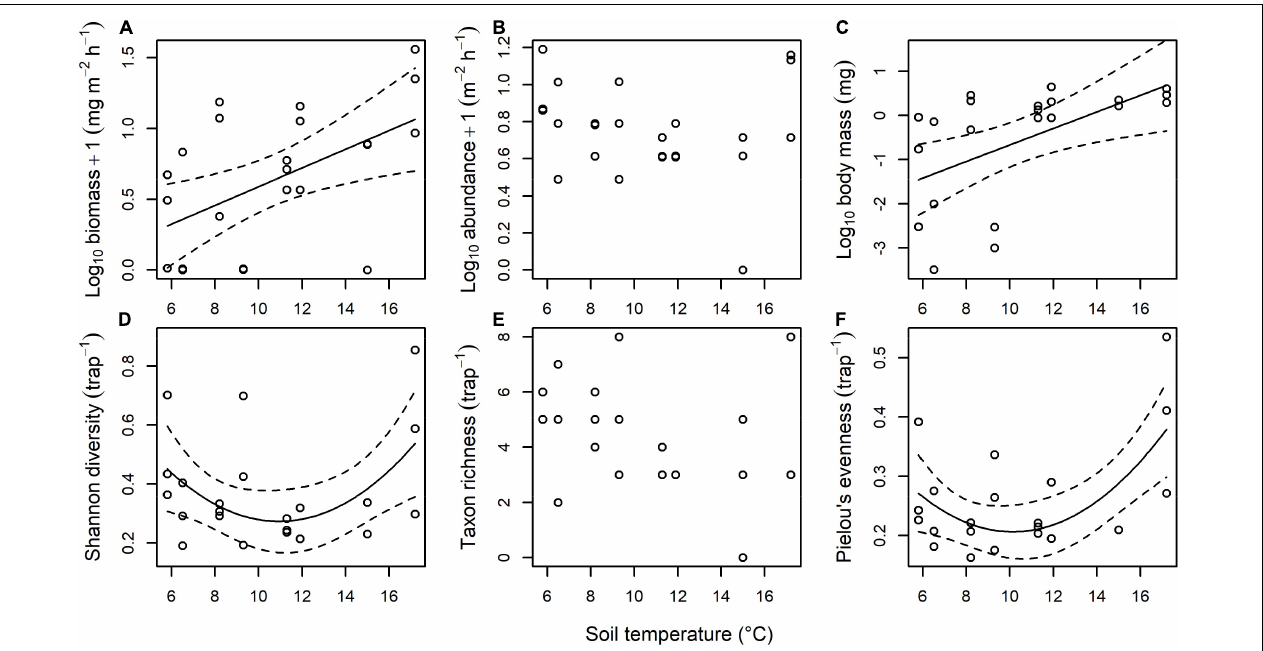
FIGURE 5 | Effect of stream temperature on the terrestrial subsidy of ground-dwelling invertebrates falling into the streams. There was a significant effect of temperature on (A) biomass ( y = − 0.071 + 0.066 x , p = 0.010, r 2 = 0.23), (C) body mass ( y = − 2.543 + 0.187 x , p = 0.008, r 2 = 0.25), (D) Shannon diversity ( y = 1.080 – 0.147 x + 0.007 x 2 , p = 0.049, r 2 = 0.19), and (F) Pielou’s evenness ( y = 0.561 – 0.070 x + 0.003 x 2 , p = 0.006, r 2 = 0.34), with no significant effect of temperature on (B) abundance or (E) taxon